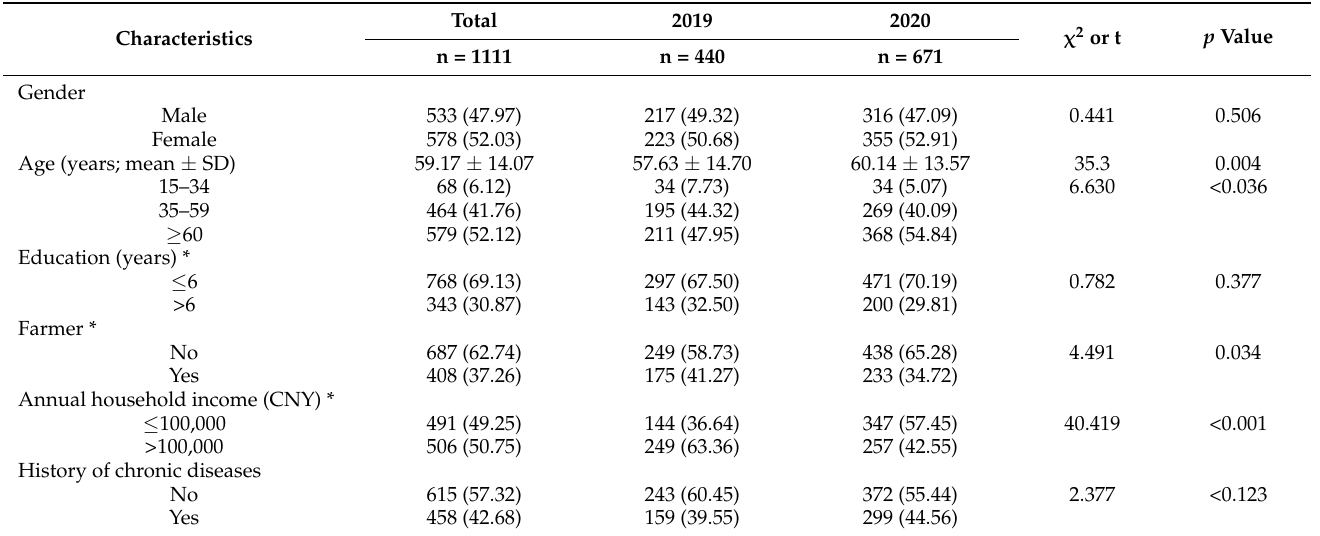
Table 1. General characteristics of the participants among the study population in Eastern China by years.